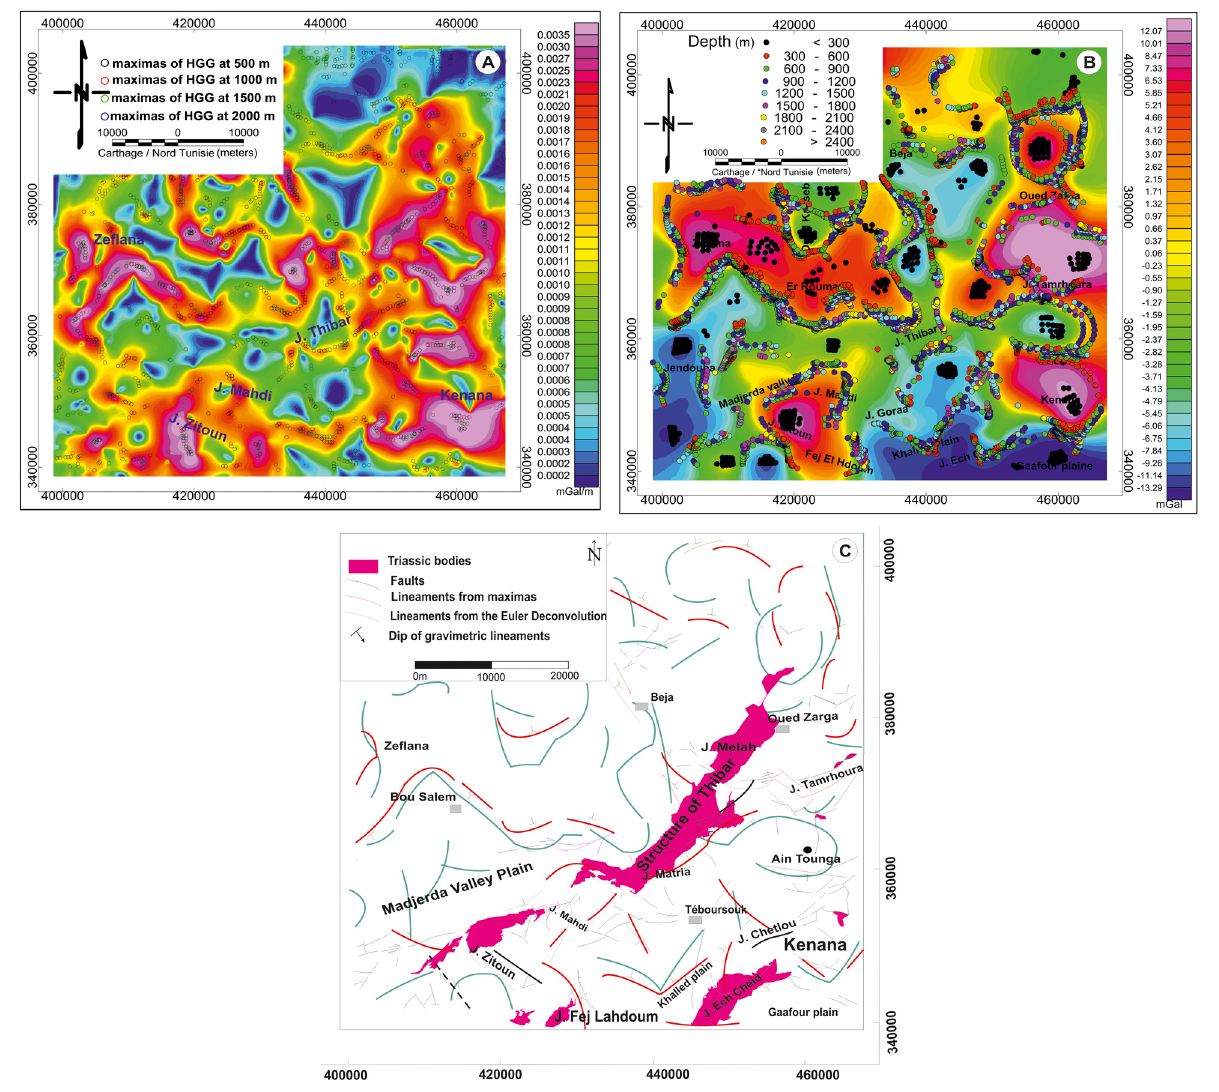
Figure 8. (A) Maxima of the horizontal gravity gradient map; (B) Euler deconvolution map superimposed on residual gravity map. The so- lutions were found using a structural index of 0.25; (C) Structural map showing lineaments deduced from gravity